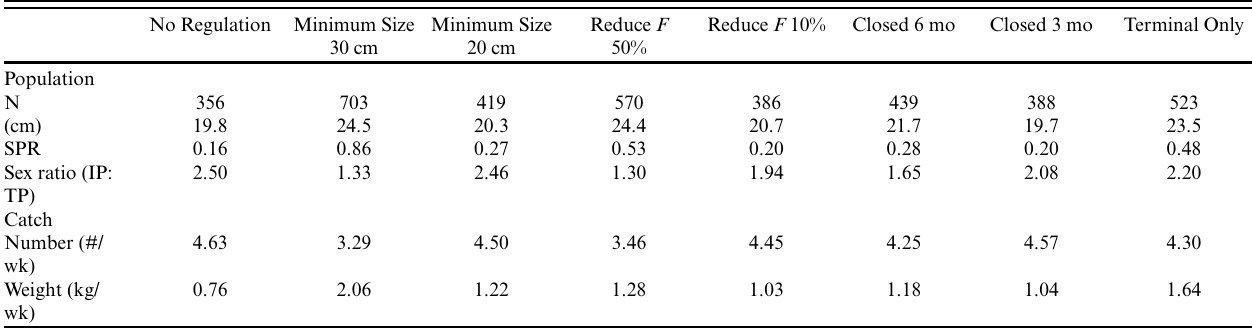
Table 4 . Mean population and catch characteristics of 3 runs after 5 years under the different harvest control rules. IP:TP, ratio of initial phase to terminal phase; SPR, spawning potential